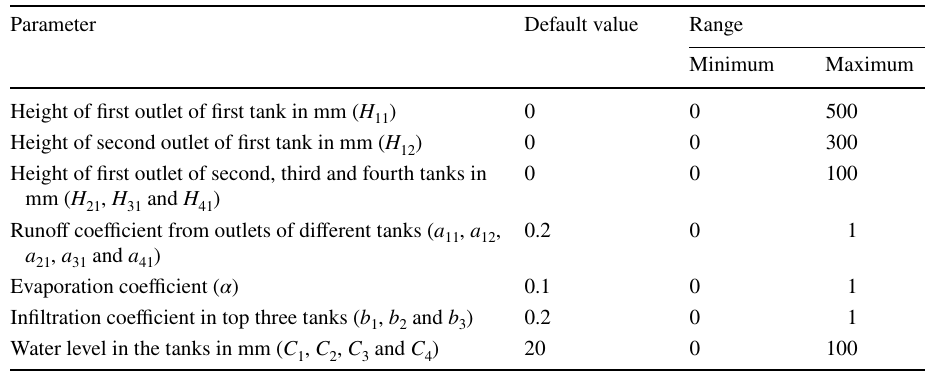
Fig. 3 Structure of AWBM in RRL. (Reproduced from RRL